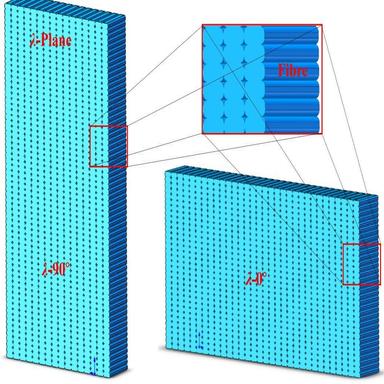
The micro-structure of the plates on λ plane.